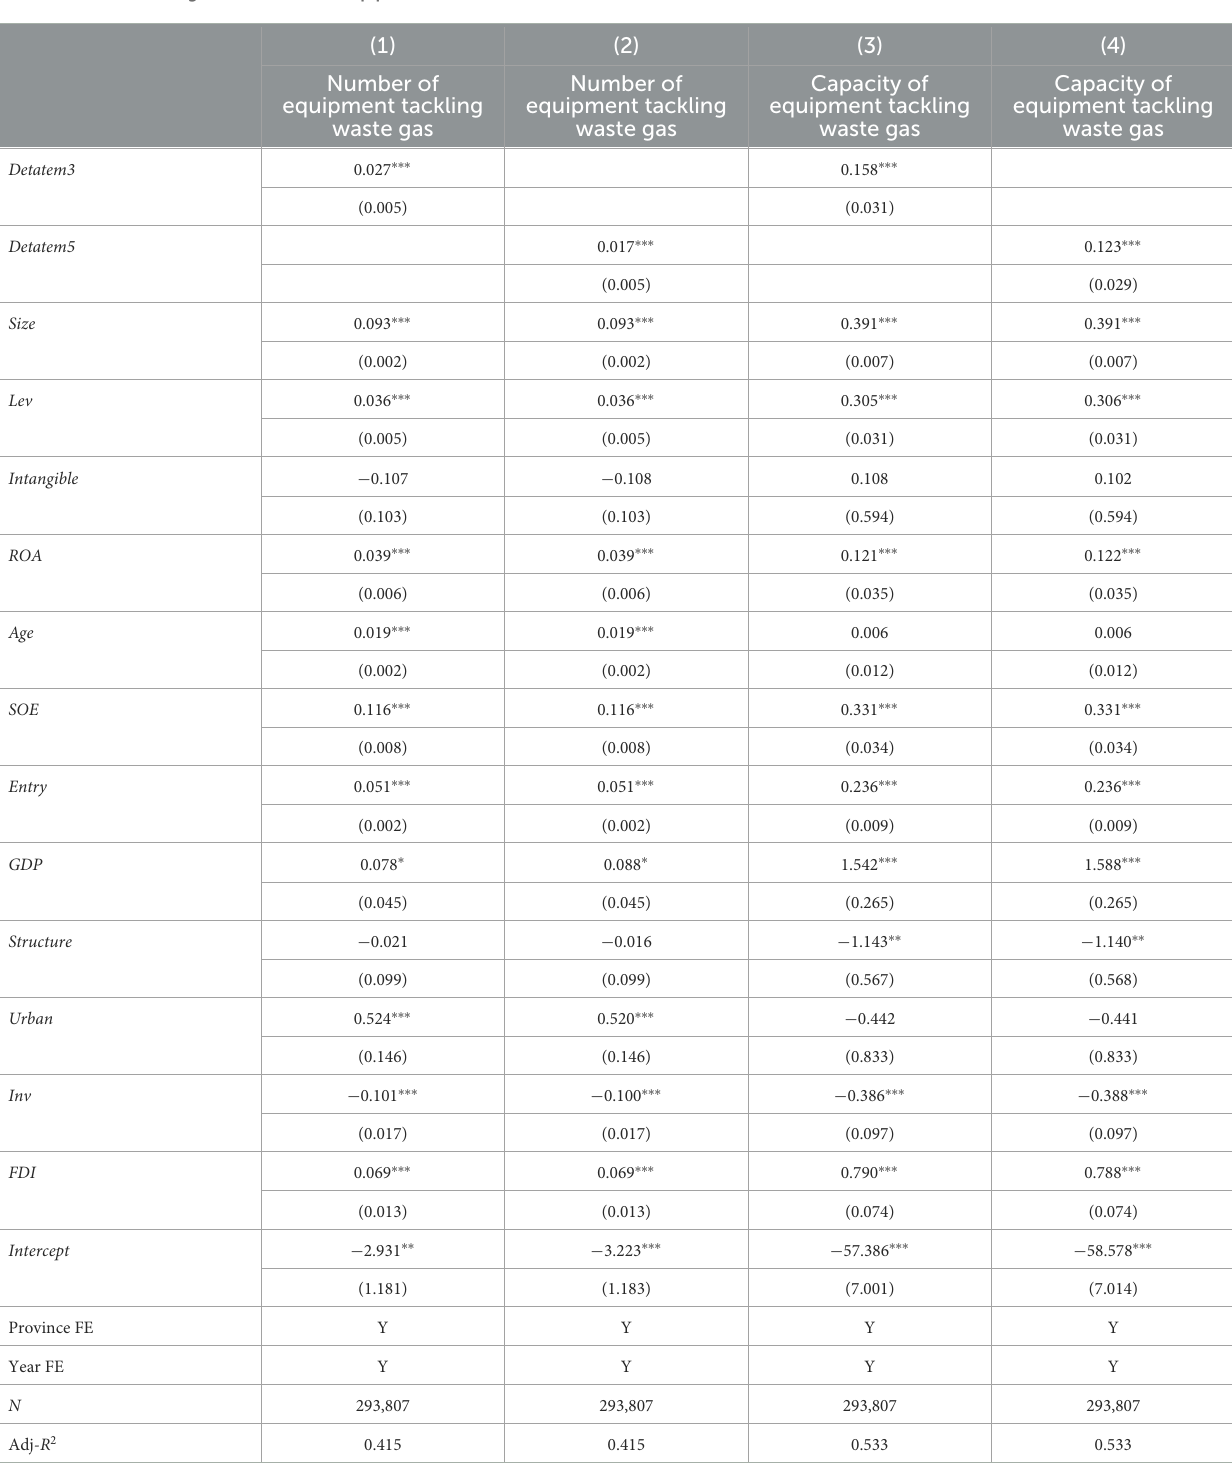
TABLE 13 Climate change and firms’ end-of-pipe